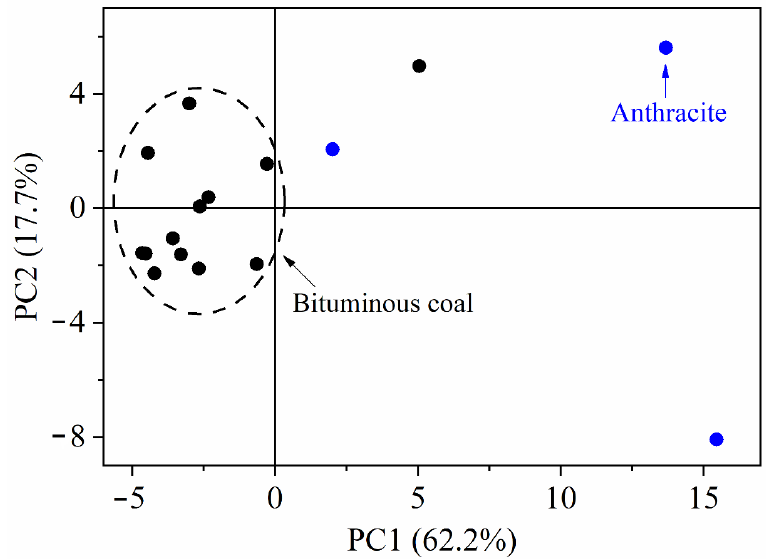
Figure 5. Score plot of 16 coal samples on the first two principal components.